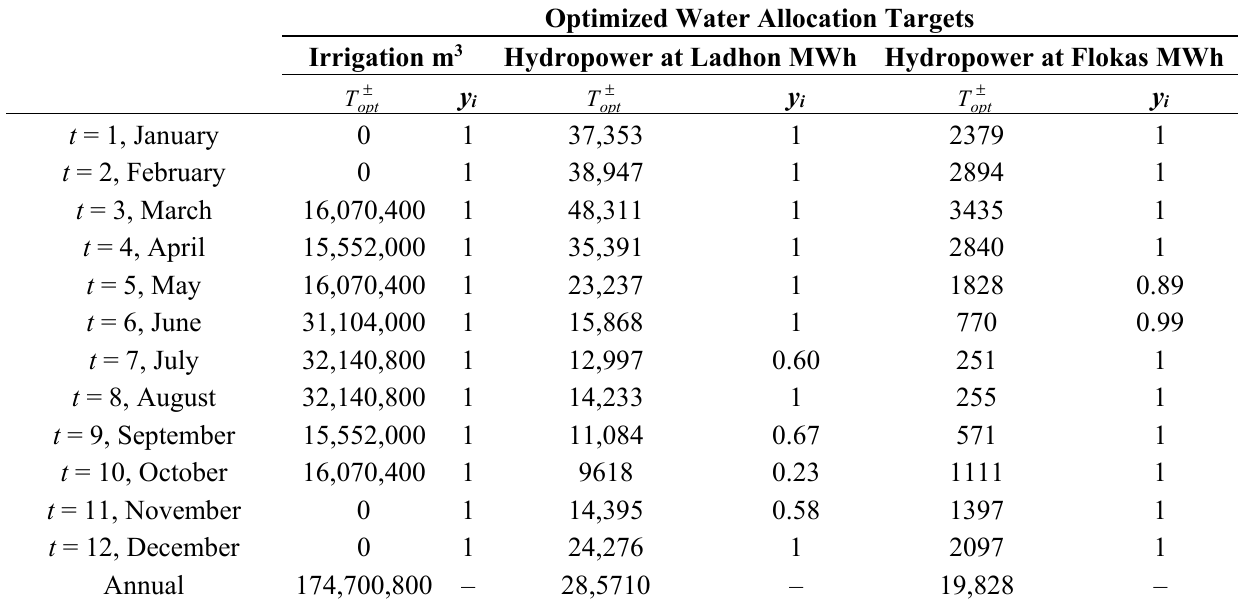
Table 15. Monthly and annual optimized water allocation